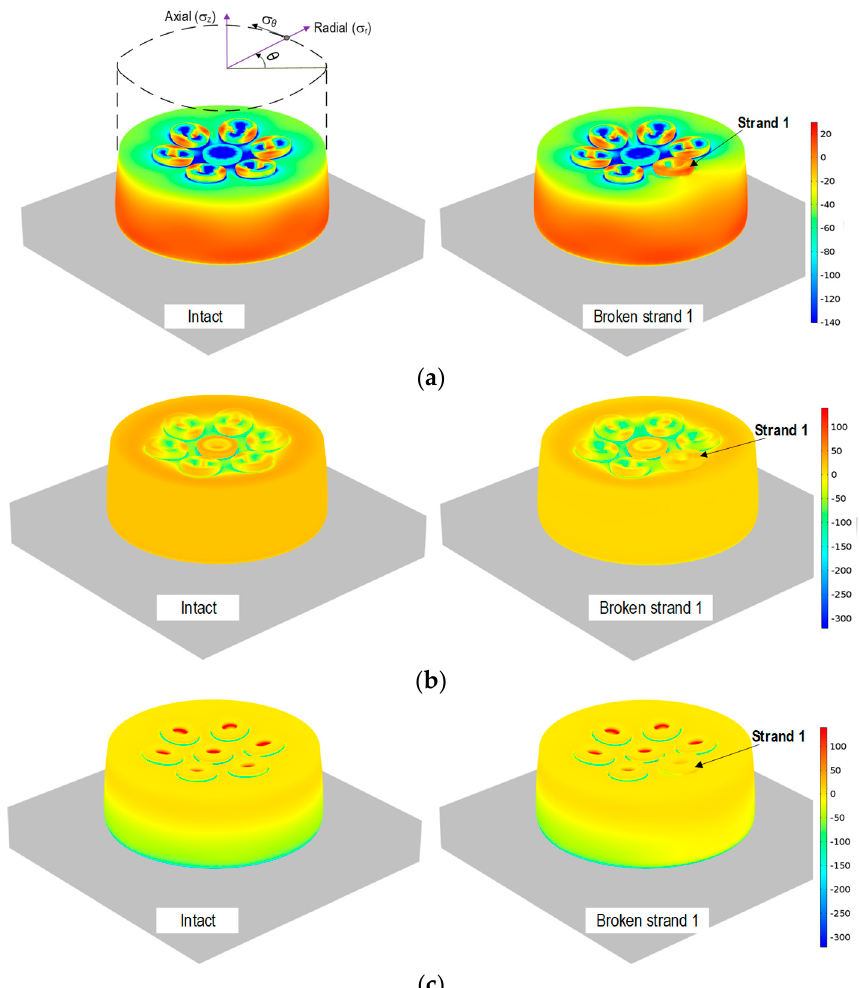
Figure 2. Variation of stress fields due to strand breakage. ( a ) Circumferential stress ( σ θ ), ( b ) radial stress ( σ r ), and ( c ) axial stress ( σ z ).